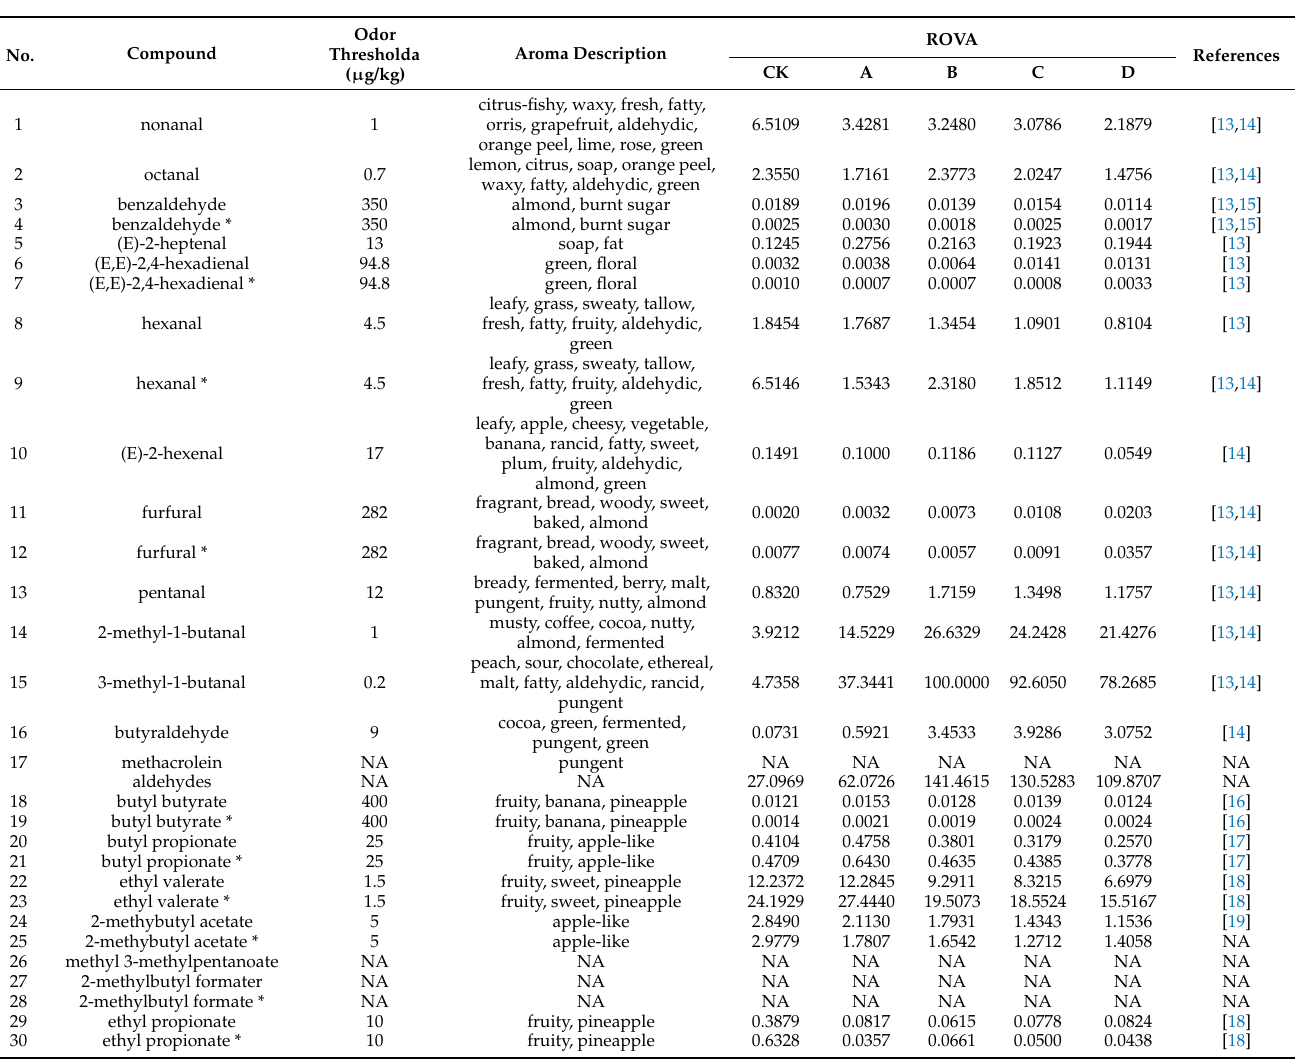
Table 2. Aroma threshold, aroma characteristics, and relative odor activity (ROAV) in pome- granate